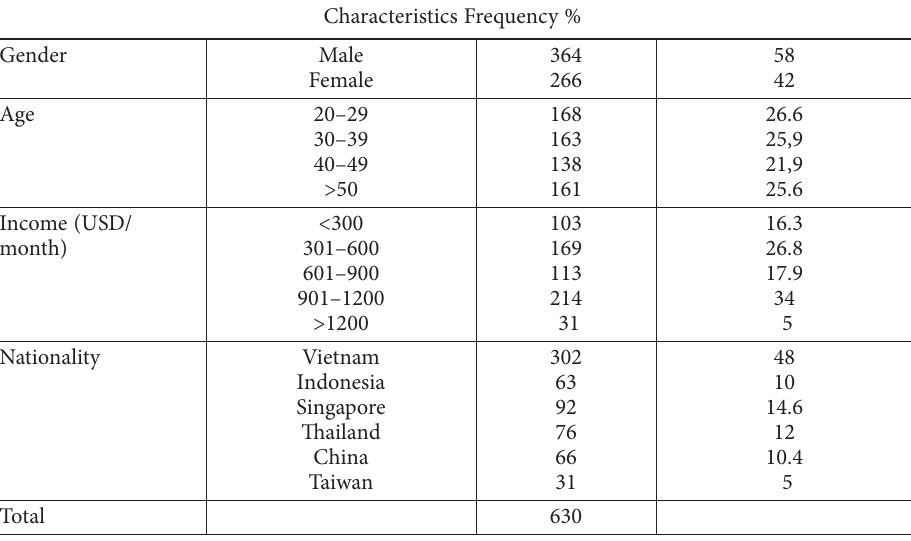
Table 1. Demographic information for the